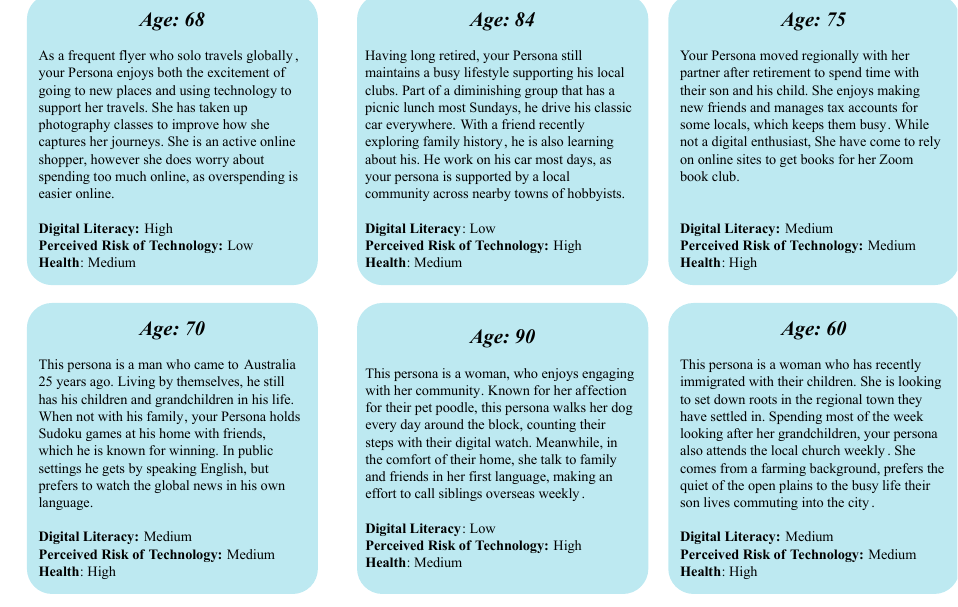
Figure 2. Basic persona profiles.